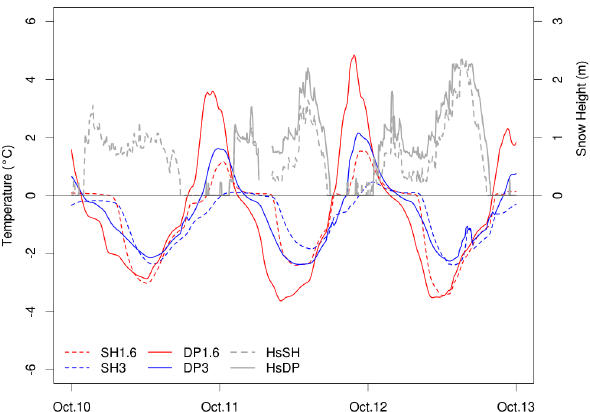
Figure 6. Fluctuations of snow cover thickness (Hs) and ground temperatures (daily mean) at selected depths in the active layers of Cime Bianche from 1 October 2010 to 30 September 2013 de- termined from borehole temperature data. Lines type: dashed is for SH, solid is for DP. Colors: red is for shallower temperatures (1.6m), blu is for deeper temperature (3m), grey is for